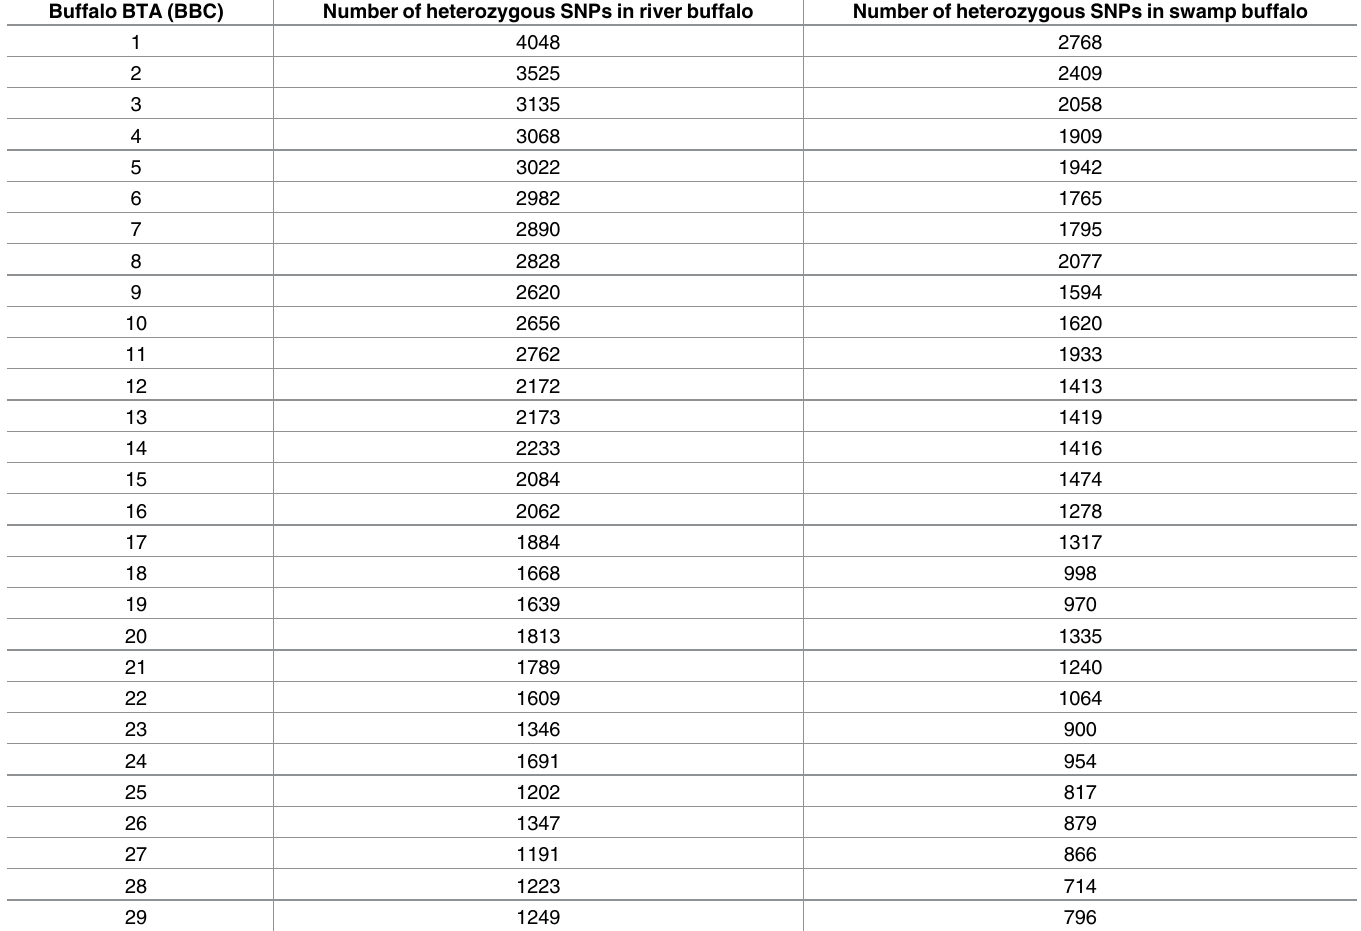
Table 1. Numbers of heterozygous SNP per chromosome. SNPs are annotatedper bovine chromosome as the buffalo genomeis not yet assignedto chromosomes. Buffalo BTA